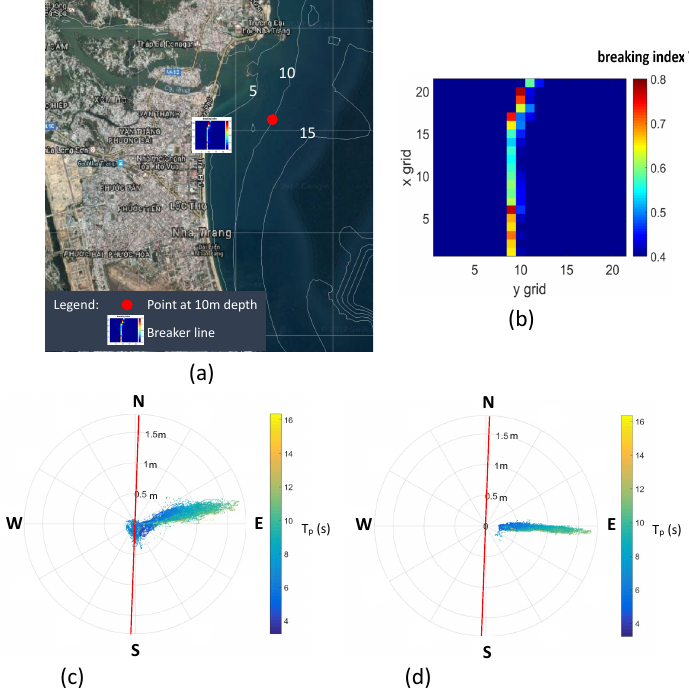
Figure 6. ( a ) Locations of point at 10m depth and of breaker line used for extracting SWAN wave characteristics. ( b ) Breaker line along the shoreline at PF1 detected from a SWAN grid region of 400 m × 400 m; colorbar indicates the breaking index. “x grid” is the index of “X”, while “y grid” is the index of “Y”; “pixel” is a grid cell of 20 m × 20 m. Directional plot of the significant wave height H s (circles) and the peak wave period T p (colorbar) from SWAN at 10m water depth ( c ) and at breaking point ( d ). The red line is the beach orientation. North (N) corresponds to 0 ◦